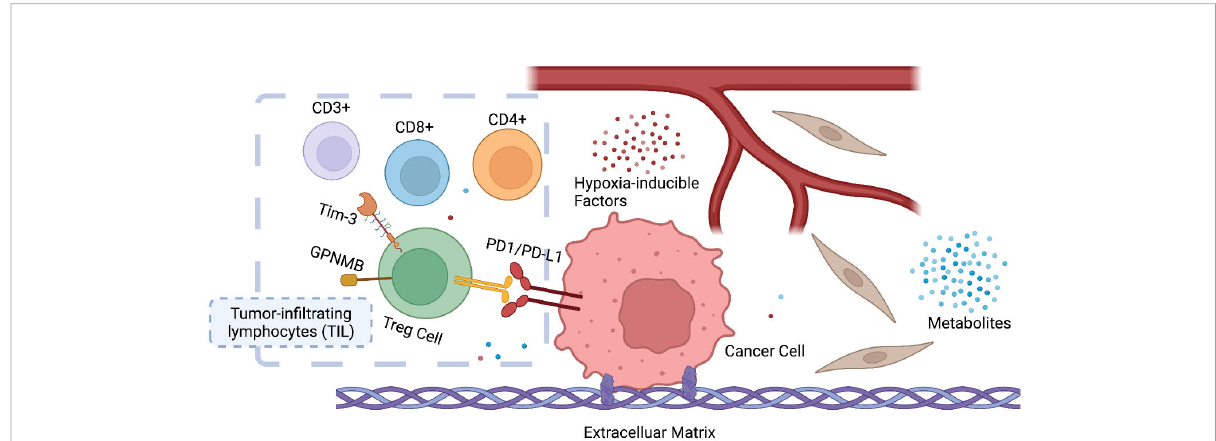
FIGURE 2 Symbiosis between cancer cells and the tumor microenvironment (TME). The in fi ltration and ratio of different lymphocytes are determined by the antigen presentation of cancer cells, which in return in fl uences tumor growth and response to therapy. Hypoxia-inducible factors (HIF) and metabolites (e.g., lactate) also play a key role in reprogramming the TME of cancer. CD3 + T-lymphocyte: T cells that mediate the activation of tumor-reactive T cells, e.g., CD8 + naive T cells and CD4 + naive T cells. CD4 + T lymphocyte: also called T helper cell, which remodels TME by releasing cytokines and mediates the anti-tumor response of CD8 + T cells by cross-presentation of dendritic cells. CD8 + T lymphocytes: also called cytotoxic T cell, the speci fi c killer that targets the surveilled cancer cells. Treg cells: also called suppressor T cells, a subpopulation of T cells that modulate the immune system, maintain tolerance to self-antigens, and prevent autoimmune disease. Treg cells are immunosuppressive and generally suppress or downregulate the induction and proliferation of effector T cells. Treg cells express CD4, FOXP3, and CD25 and are thought to be derived from the same lineage as naïve CD4 + cells. Since effector T cells also express CD4 and CD25, it is dif fi cult to effectively distinguish Treg cells from effector CD4 + cells, making them dif fi cult to study.